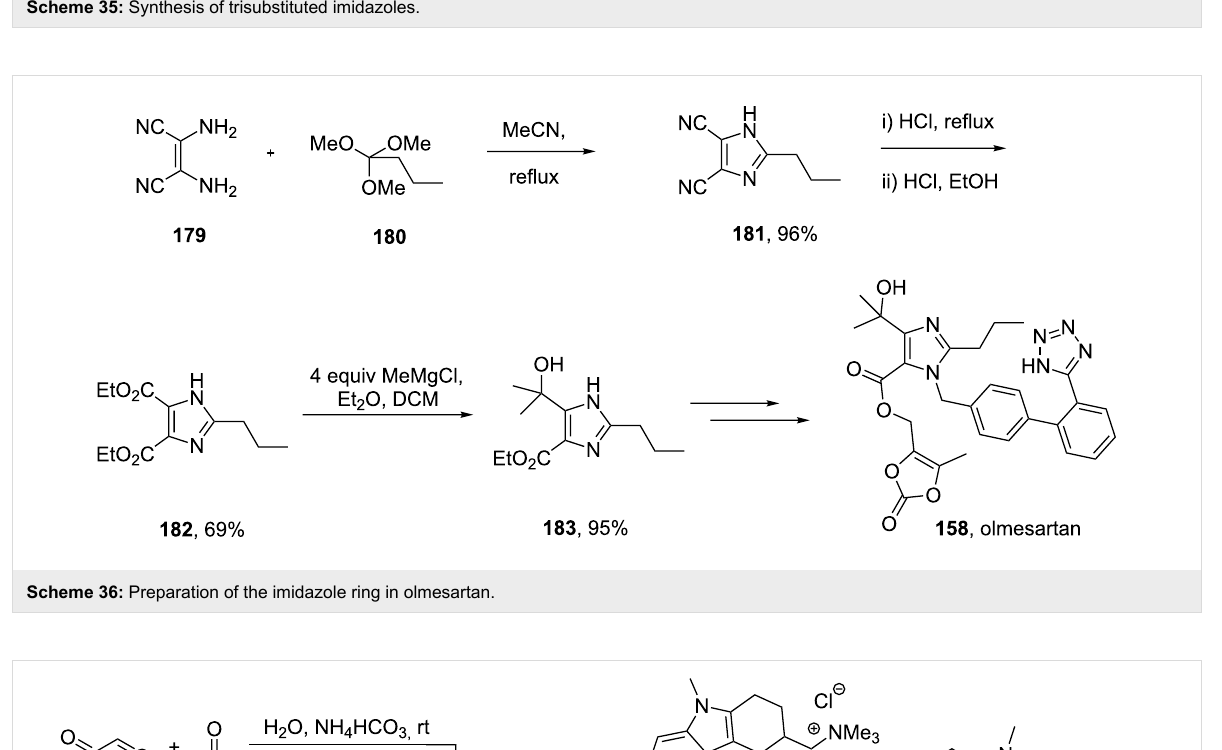
Scheme 35: Synthesis of trisubstituted imidazoles.